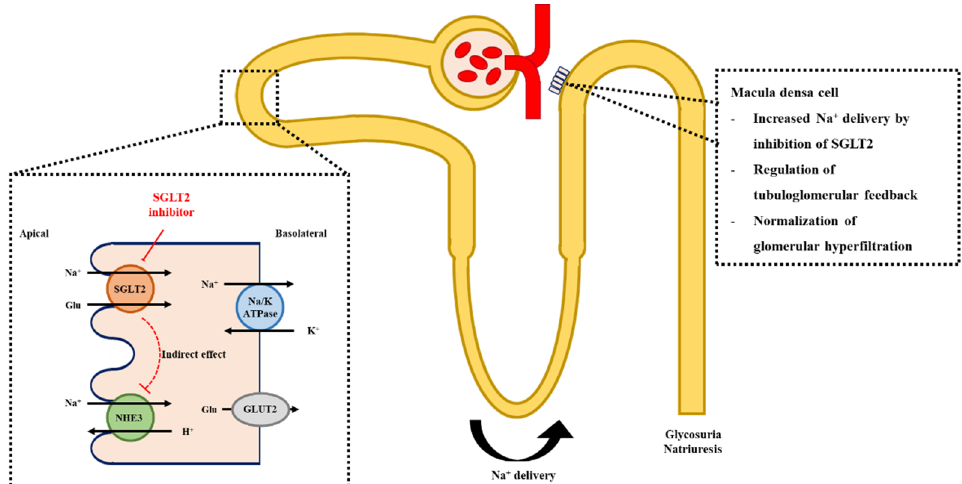
Figure 2. Mechanism of SGLT2 inhibition and the regulation of tubuloglomerular feedback. Inhibition of SGLT2 indirectly suppresses the activity of NHE3, leading to increased Na + delivery to the distal part of the nephron. The elevation of Na + concentration and increased luminal flow activate the tubuloglomerular feedback and decrease intraglomerular pressure. SGLT2; sodium-glucose cotransporter-2, NHE3; Na + /H + exchanger 3.